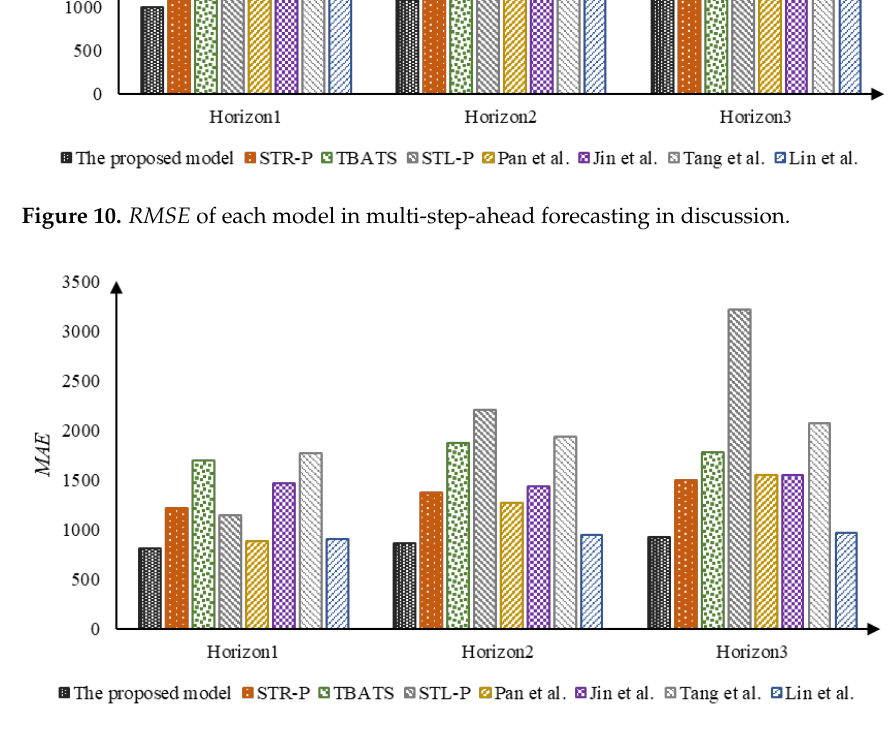
Figure 11. MAE of each model in multi-step-ahead forecasting in discussion. Table 9. Results of the DM test in discussion.